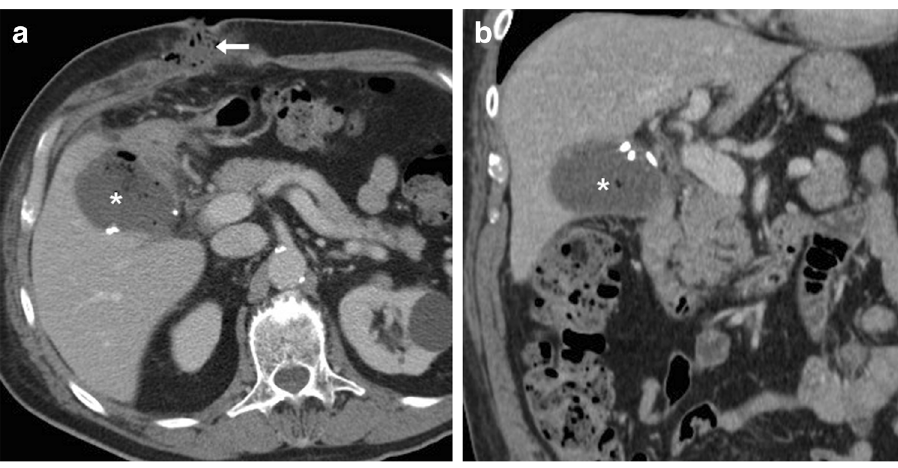
Fig. 3 Three days after open cholecystectomy for gallbladder empyema, a non-infected postop- erative collection (* in a and b ) with mildly inhomogeneous fluid content and gas bubbles was seen occupying the gallbladder fossa abutting the surgical clips, and regressed without directed proce- dures. Additionally, clinically di- agnosed wound infection appears as inhomogeneous fluid material with sparse gas bubbles ( arrow in a ) at the laparotomy incision